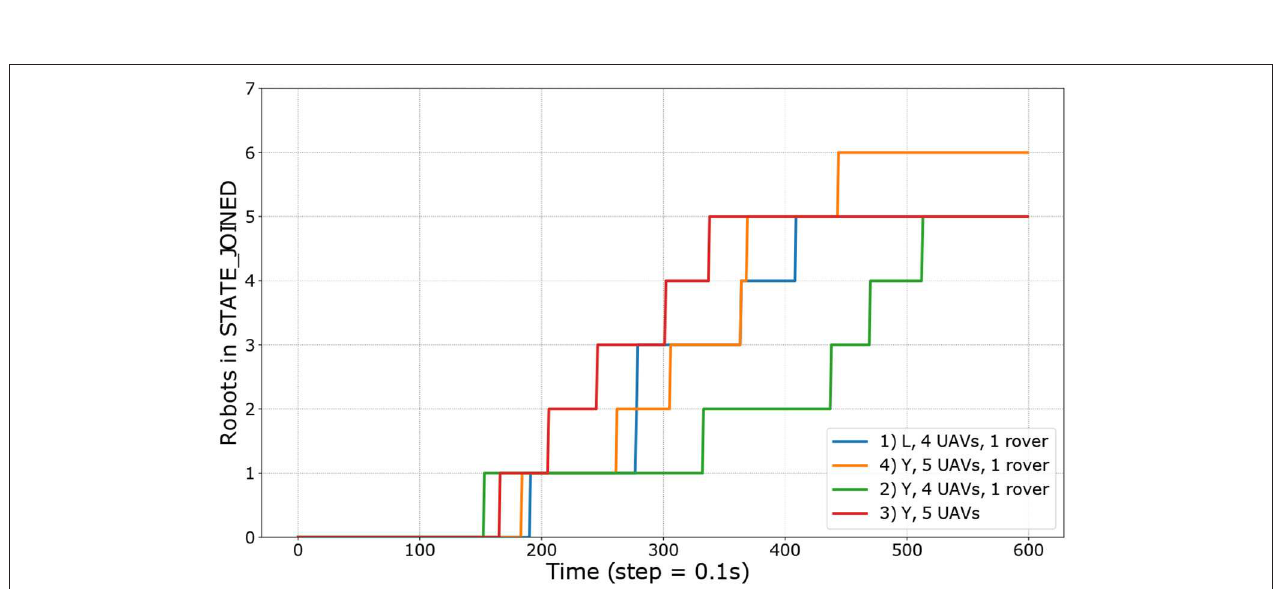
FIGURE 8 | Time required for all the robots to join on each of the four experiments conducted. Four experiments had five robot while the orange one had six. To reach the STATE_JOINED , each robot has to reach the physical location of its task.